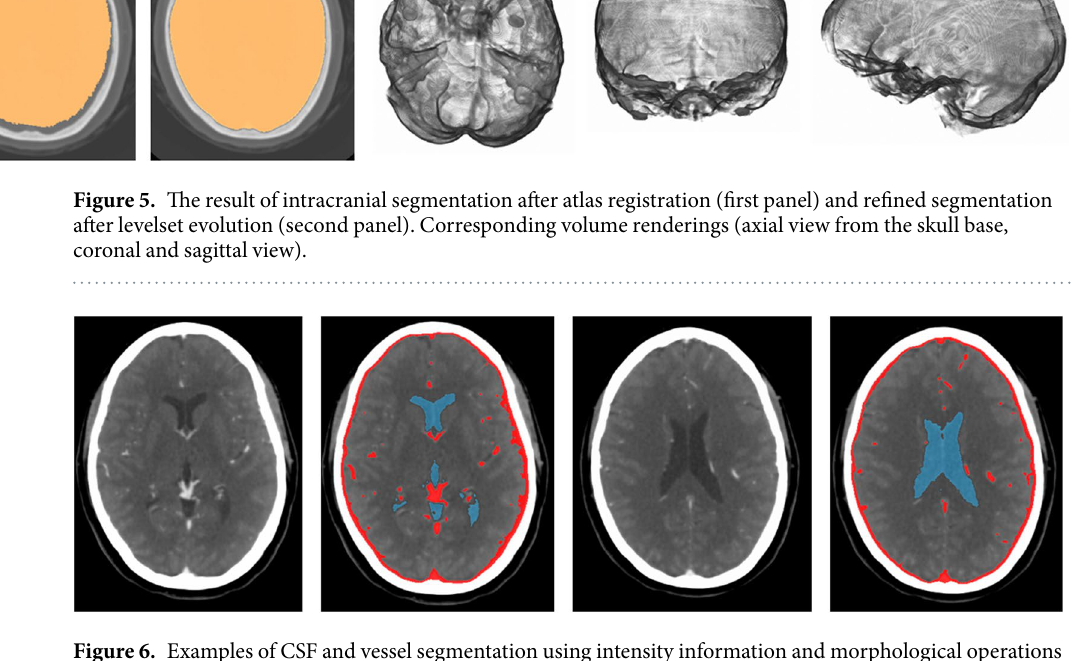
Figure 6. Examples of CSF and vessel segmentation using intensity information and morphological operations in the WTA image (window level/width 100/300 HU). These structures are masked in the intracranial image before WM and GM